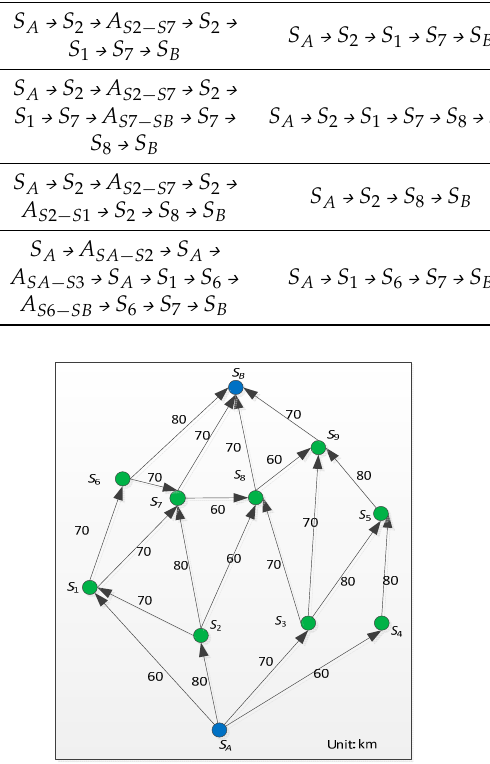
Table 2. Results of optimum path selection for different traffic accidents.